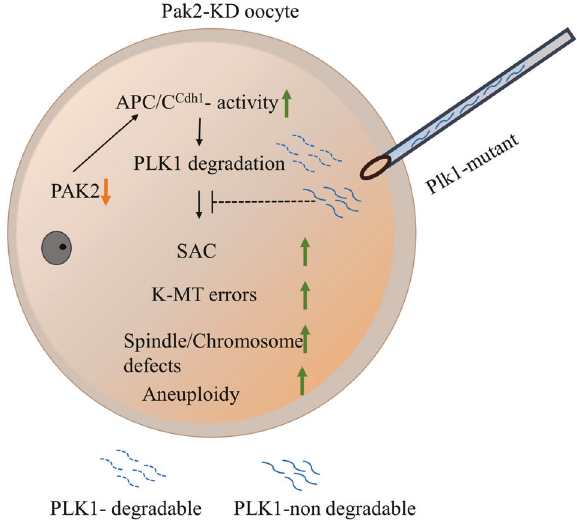
Fig. 7 Proposed model of PAK2 in meiotic progression and meiotic apparatus assembly in mice oocytes. When PAK2 level reduced in oocytes, incerased APC/C Cdh1 activity promotes PLK1 degradation and thus cause oocyte meiotic abnormality. Micro- injection of nondegradable Plk1-mutant in vitro can partially rescued these